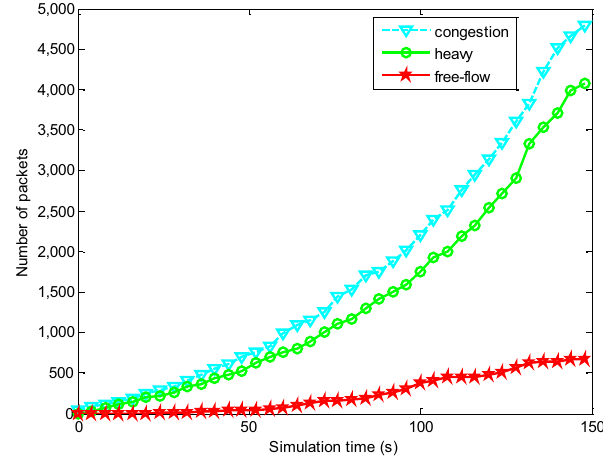
Figure 7 Distribution of the number of copies over the simulation times for different traf fi c conditions